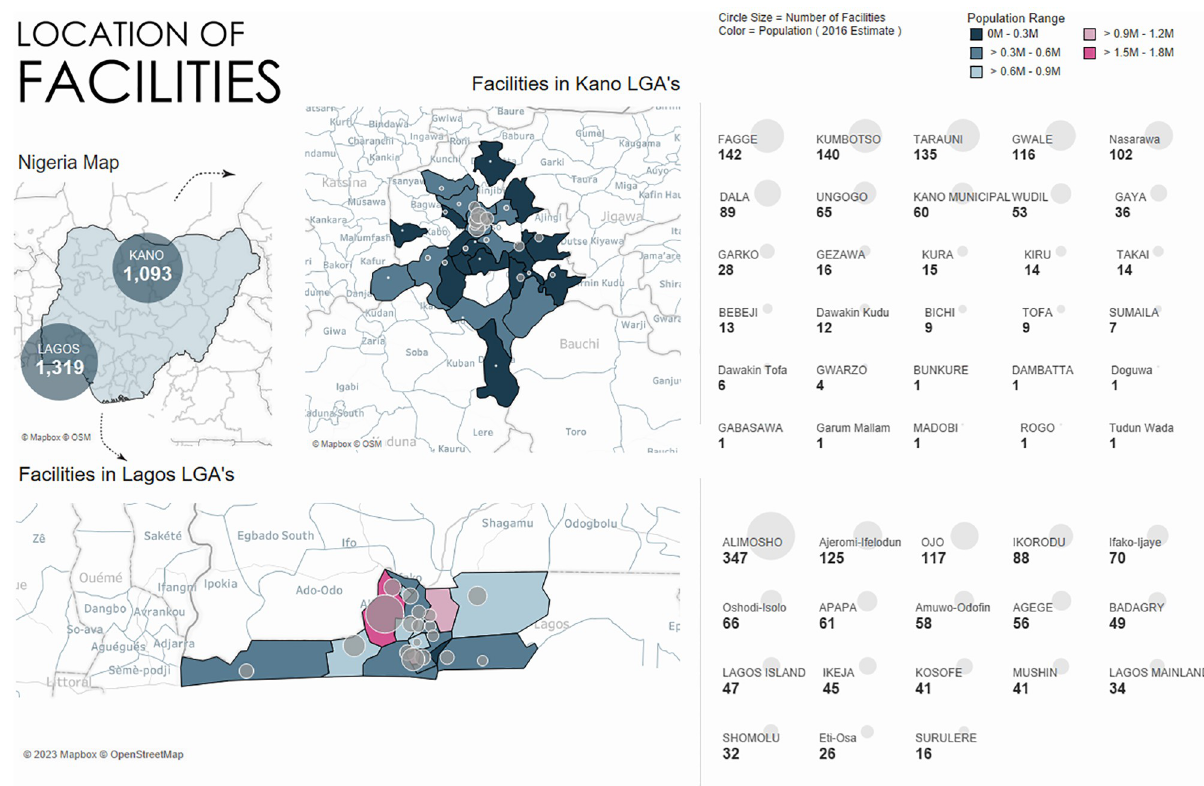
Fig 1. Location of facilities in Kano and Lagos.